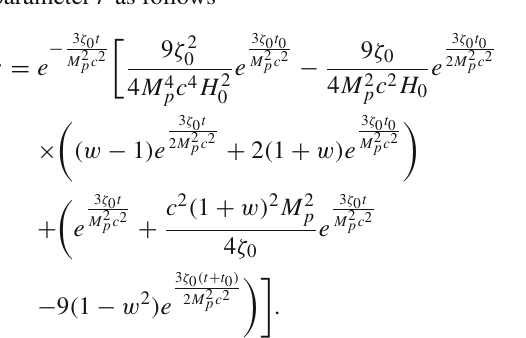
parameter r as follows